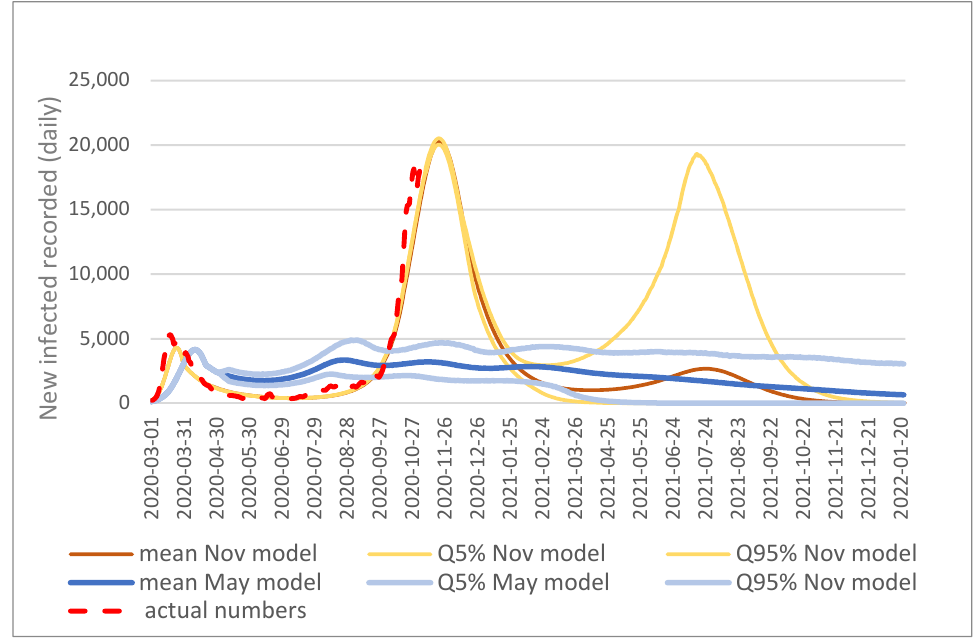
Figure 2. New infections recorded (daily); forecast mean value and bandwidth of both models.